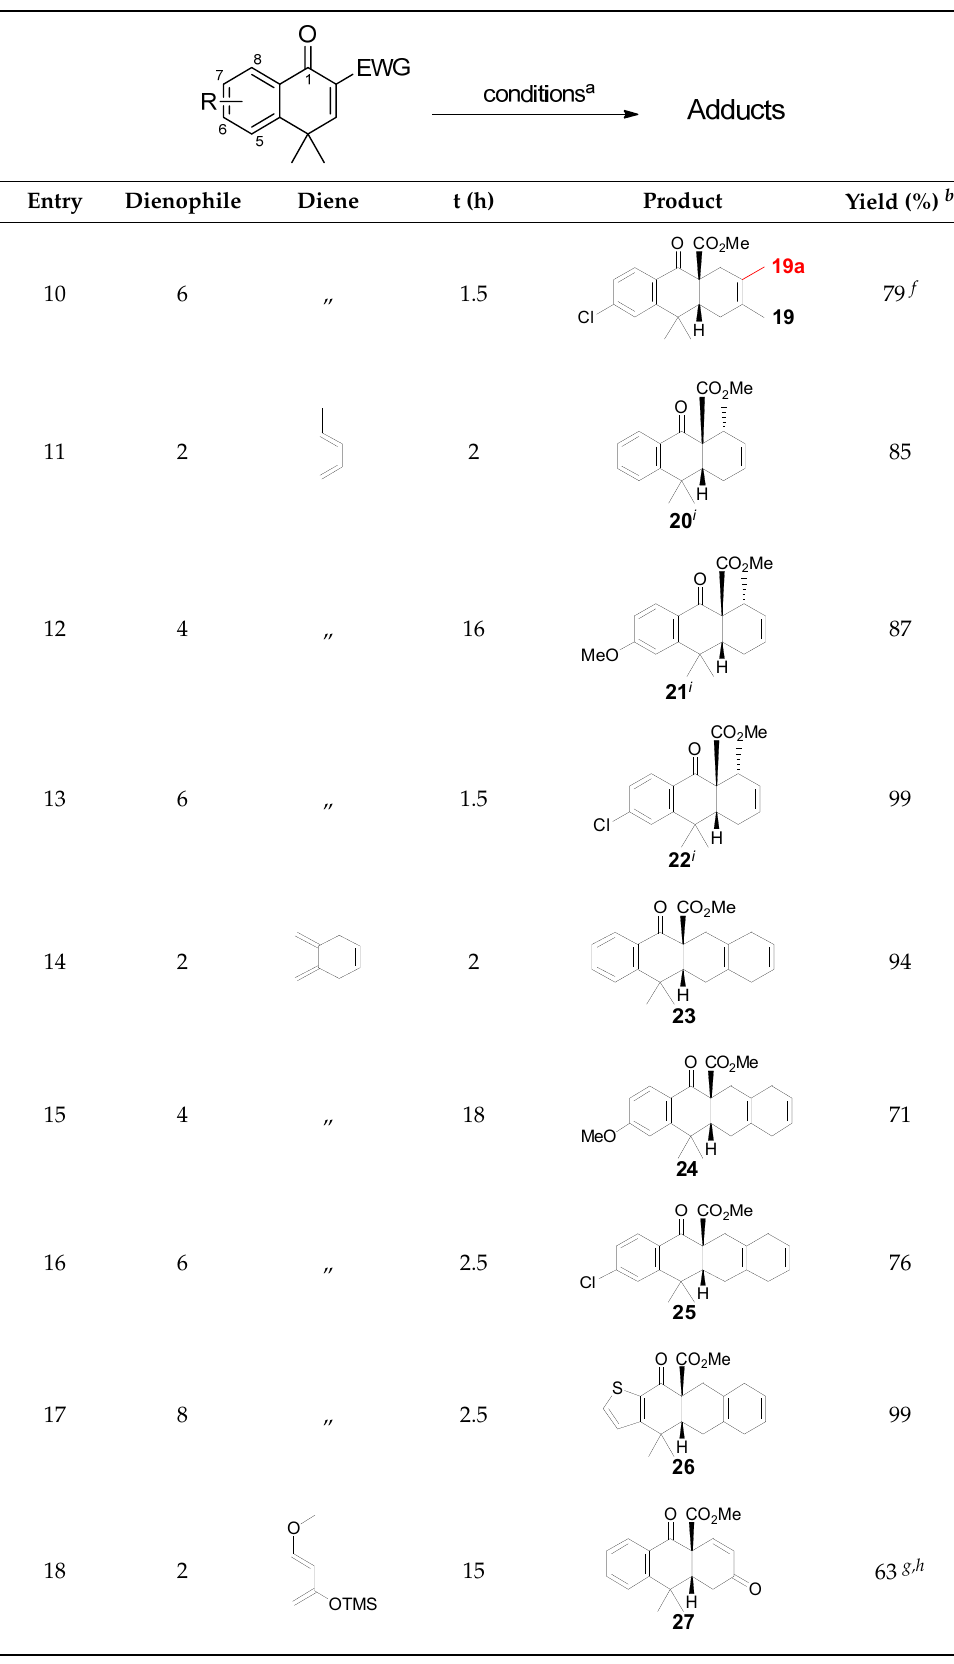
Table 2. Cont. Table 2. Scope of dienophiles and dienes applied for Diels–Alder cycloaddition a